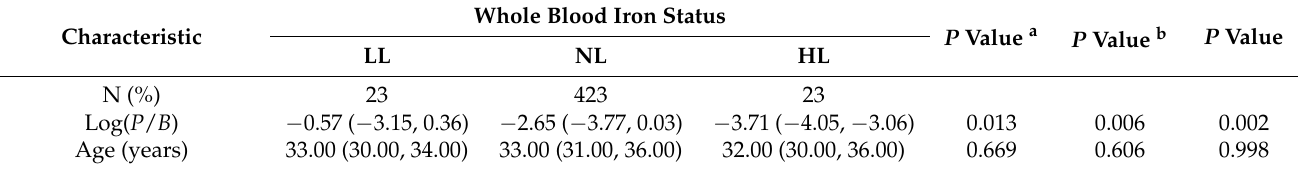
Table 4. Description of the diet and baseline information in infertile participants categorized by whole blood iron